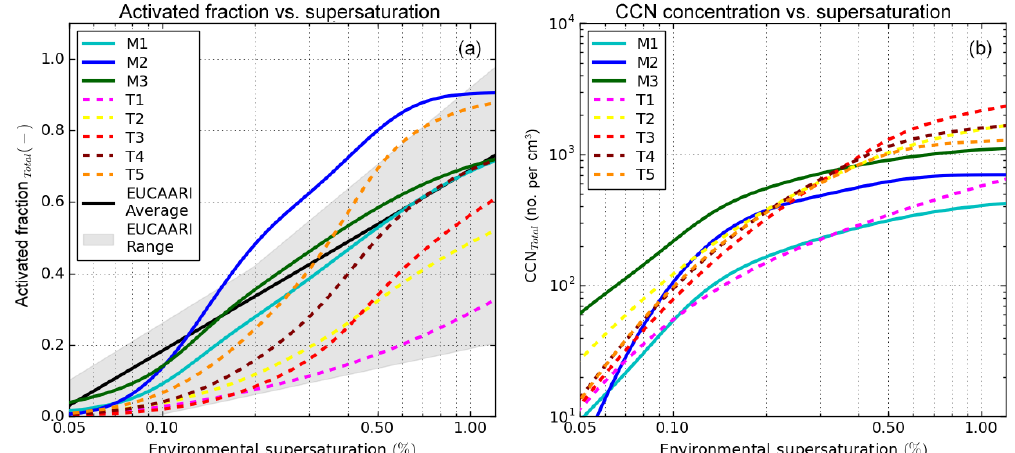
Figure 6. (a) Best-fit activated fraction spectra for each cluster in the eight-cluster K -means analysis, with marine aerosol population types plotted as solid lines, and terrestrial clusters types as dotted lines. Cluster average spectra are compared against the maximum and minimum values (grey shading) and overall average (black line) reported by Paramonov et al. (2015) from a range of sampling locations in the European EUCAARI network. (b) Parameterized mean CCN concentrations across the same range of supersaturation values for each cluster in the eight-cluster K -means